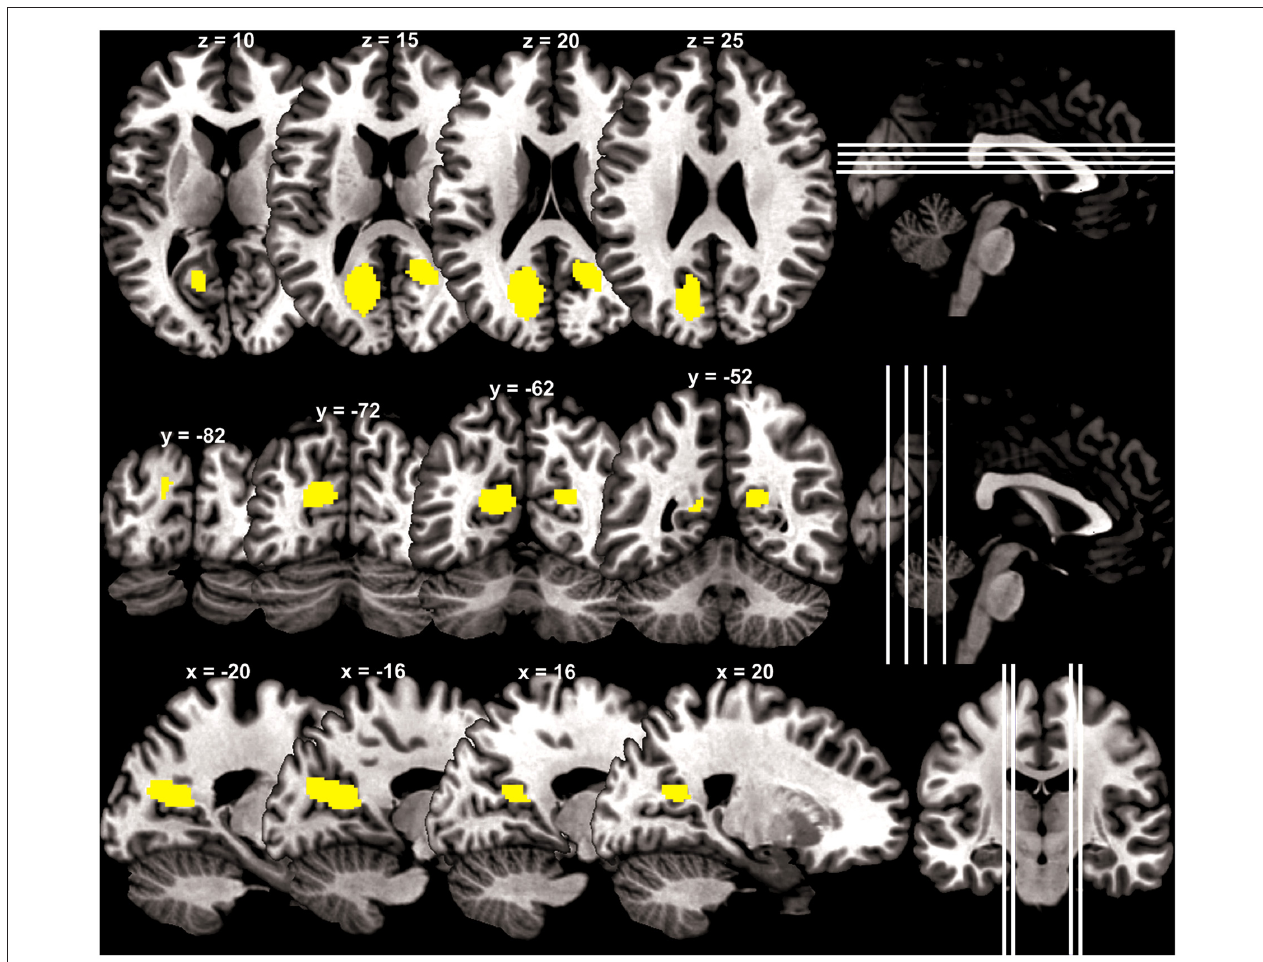
FIGURE 1 | Brain regions (yellow) with gray matter volume (GMV) increasing with impulsivity overlaid on a structural template in axial, coronal and parasagittal